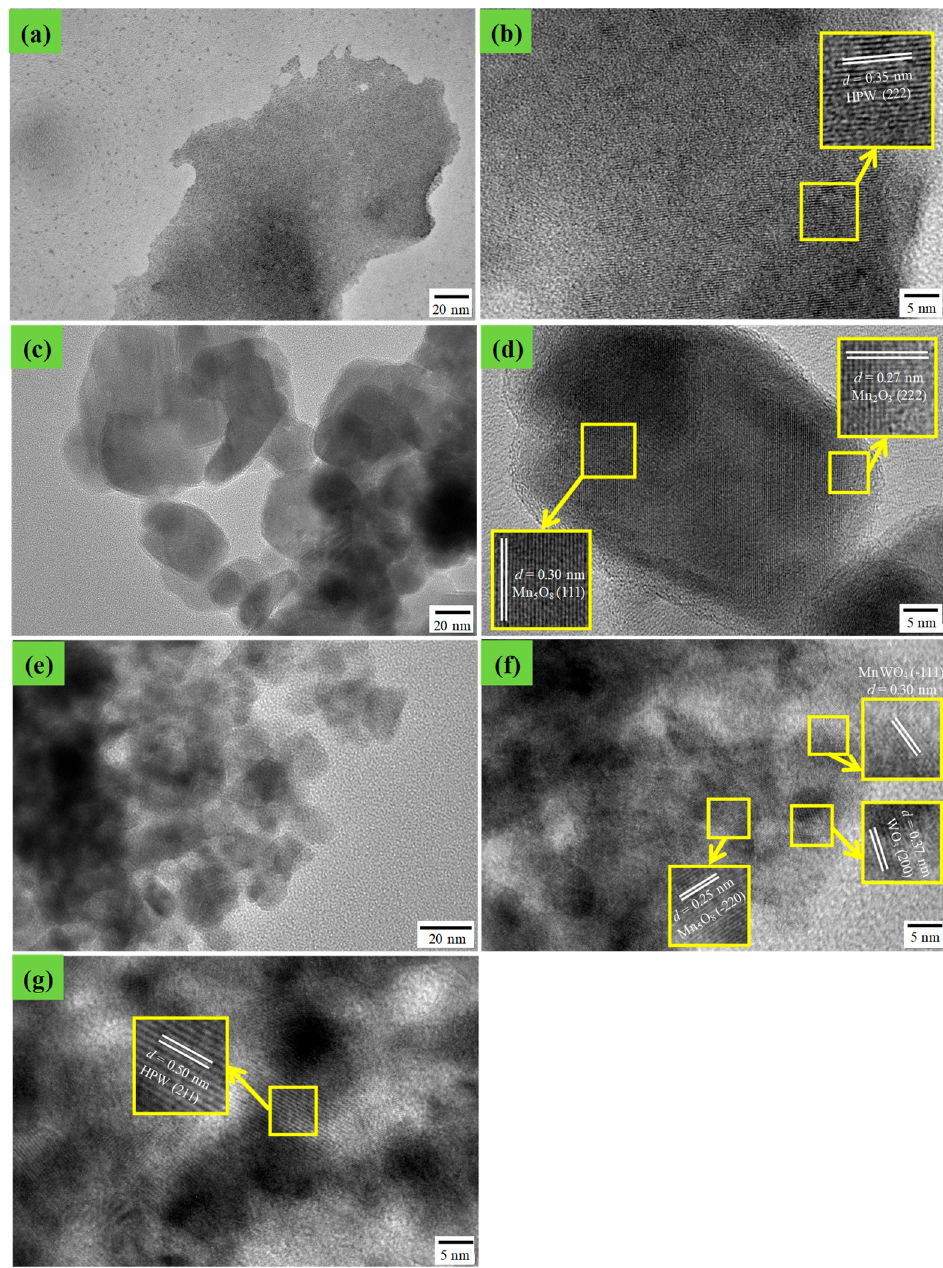
Figure 4. TEM images of HPW ( a , b ), Mn ( c , d ), and Mn-HPW 0.02 ( e – g